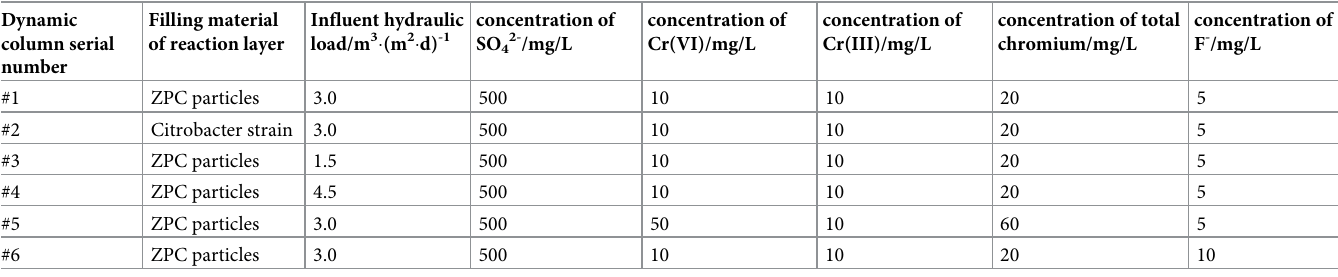
Table 1. Operating conditions of the dynamic column experiment.